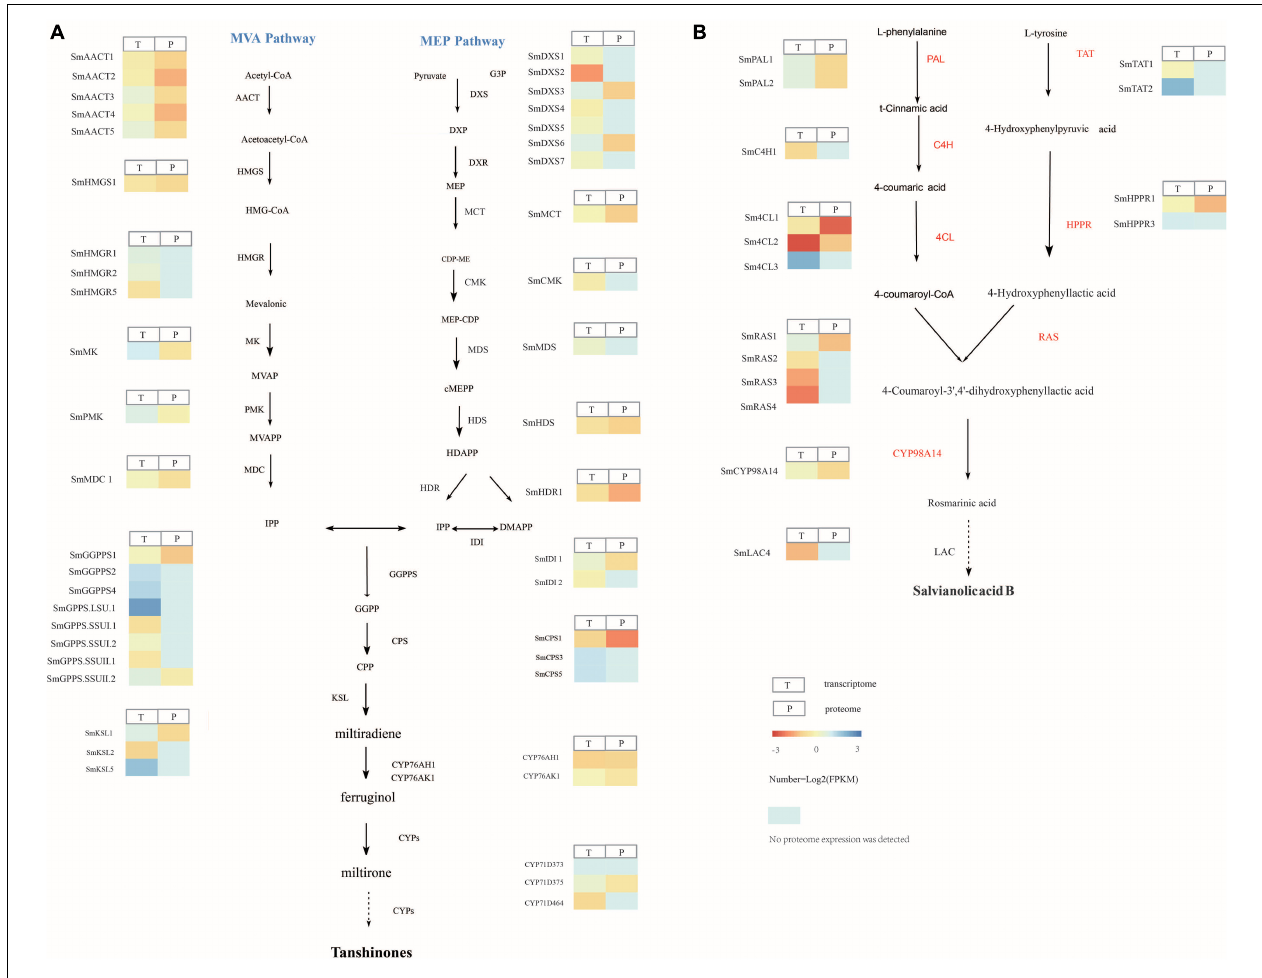
FIGURE 2 | Gene and protein expression in S. miltiorrhiza and S. castanea . (A) Gene expression heatmap for the tanshinone pathways. (B) Gene expression heatmap for the salvianolic acid pathways, displaying relative expression levels at the transcriptome (T) and proteome (P) levels. The expression level means Z-score of log2FC ( S. castanea / S. miltiorrhiza ) of transcriptome and quant ratio of the proteome ( S. castanea / S. miltiorrhiza ). Source data underlying this Figure are provided in Supplementary Tables 16, 17 .